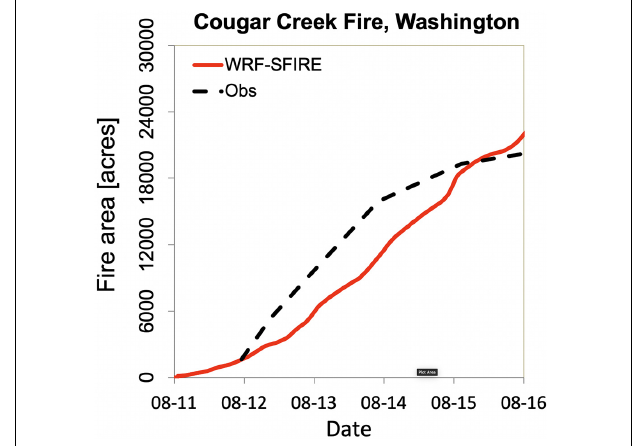
FIGURE 3 | Observed vs. WRF-SFIRE predicted fire area for the Cougar Creek Fire in August